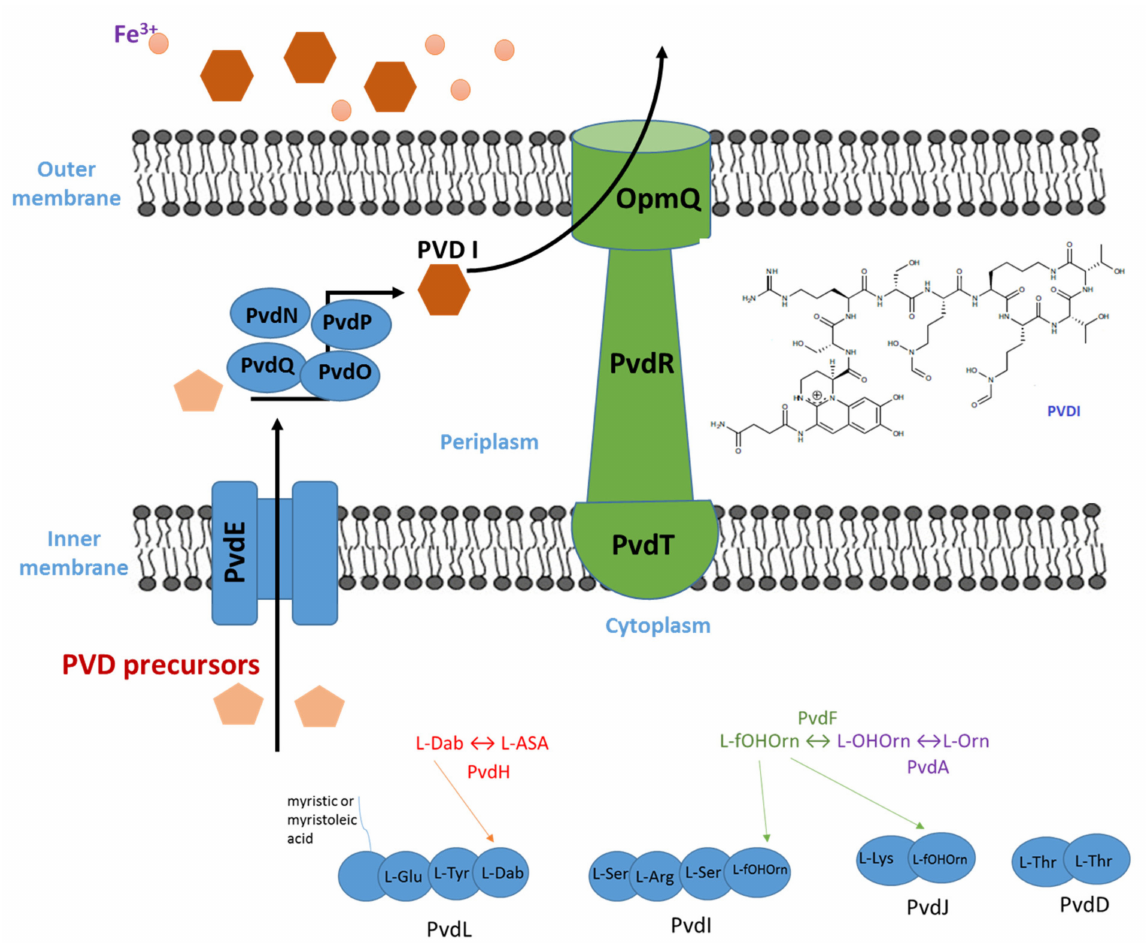
Figure 2. Biosynthesis of pyoverdine